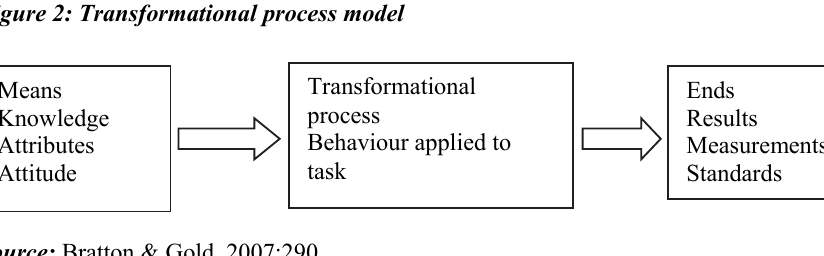
Source: Bratton & Gold,